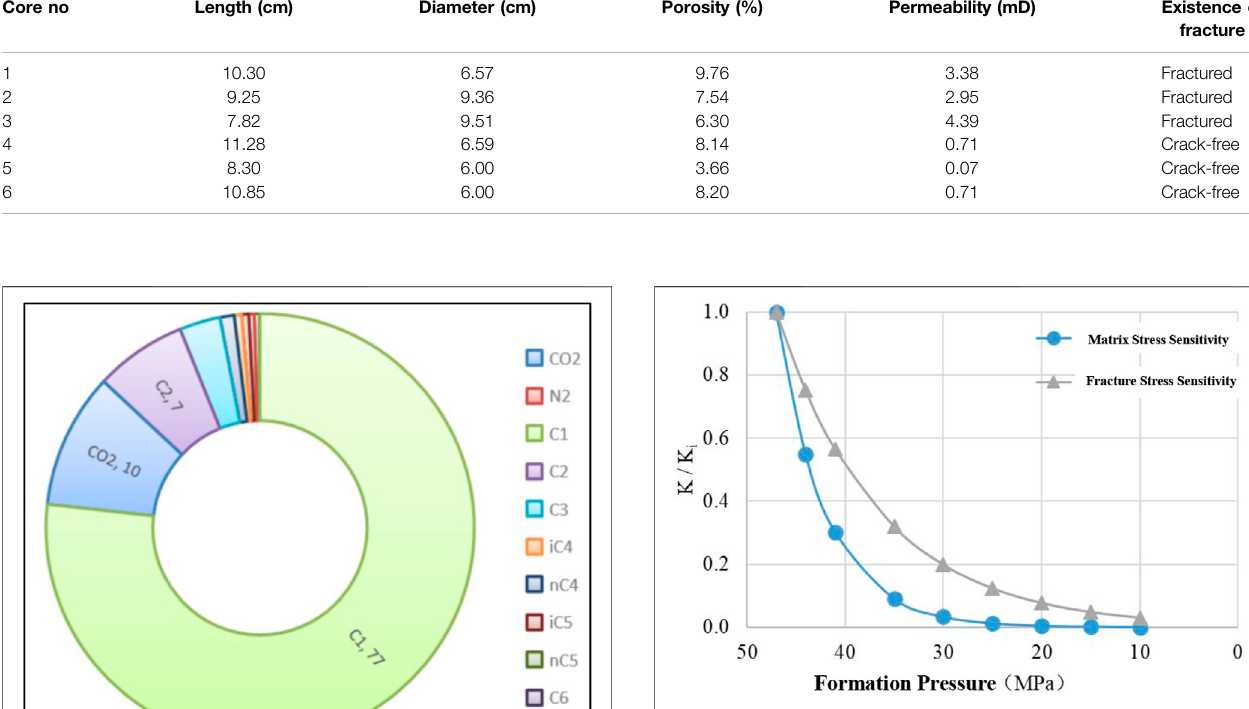
Frontiers in Earth Science |